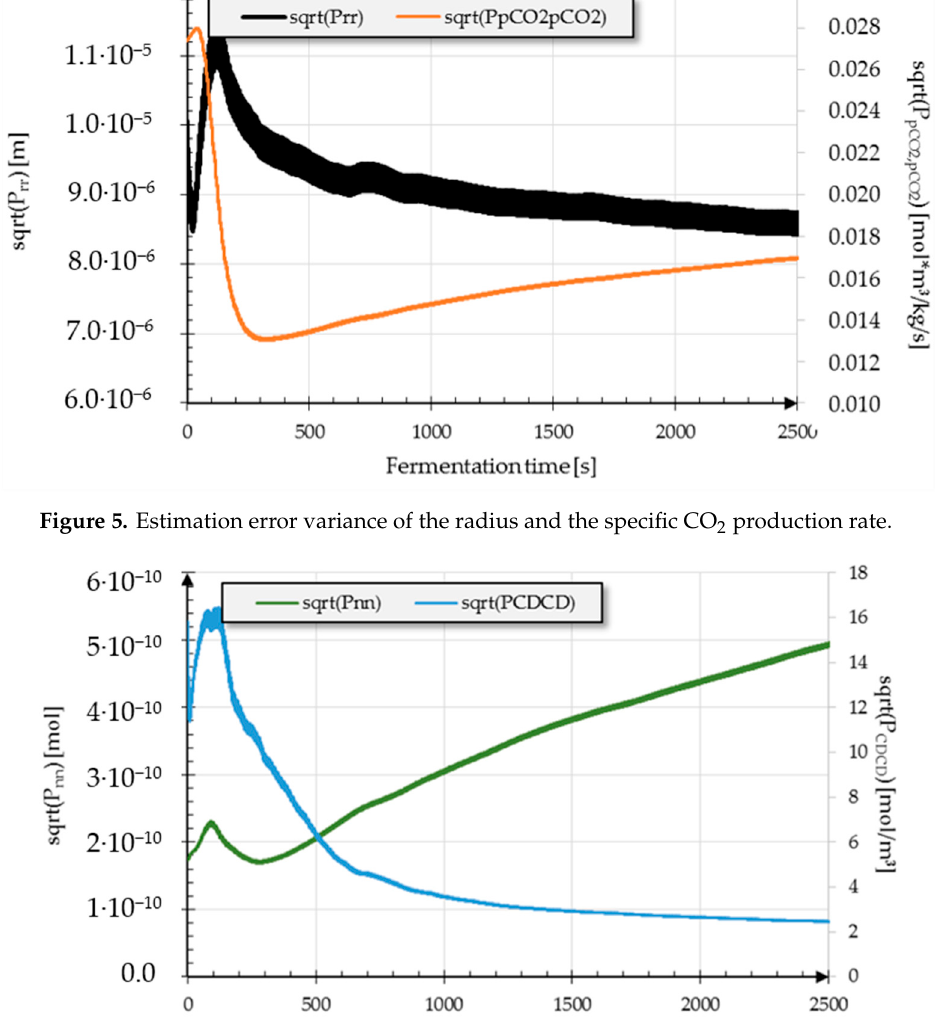
Figure 5. Estimation error variance of the radius and the specific CO 2 production rate.